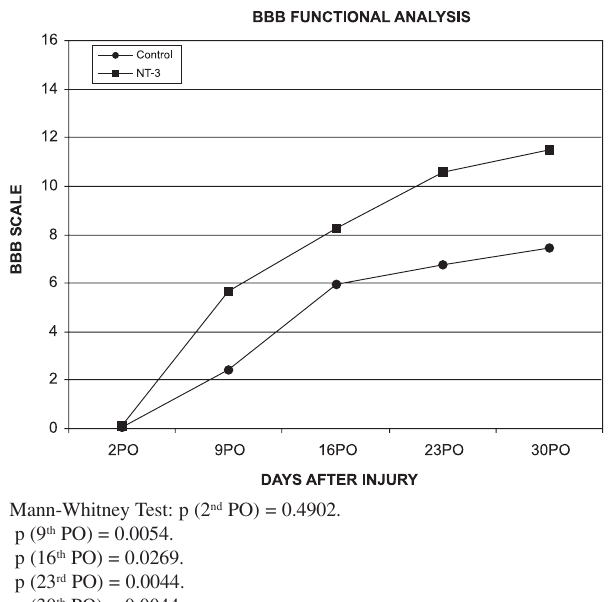
Figure 2 - Control and NT-3 Groups Functional